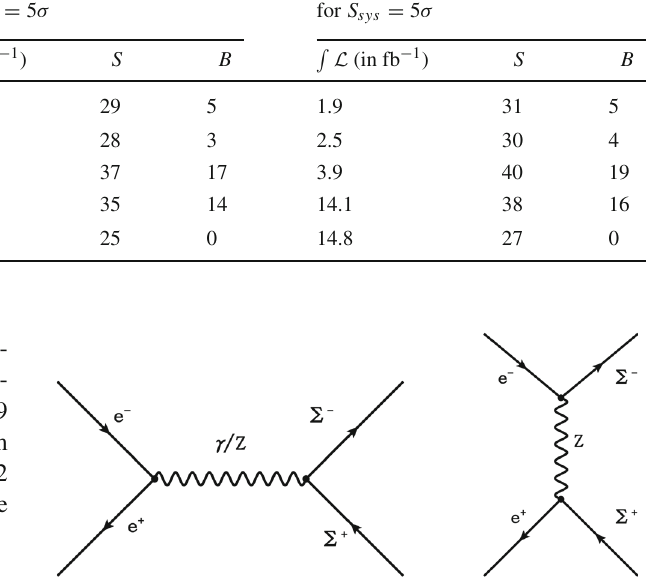
Table 5 Luminosity requirement for signal significance of 5 σ for different final states of the processes e − e + → (cid:2) ± e ∓ and